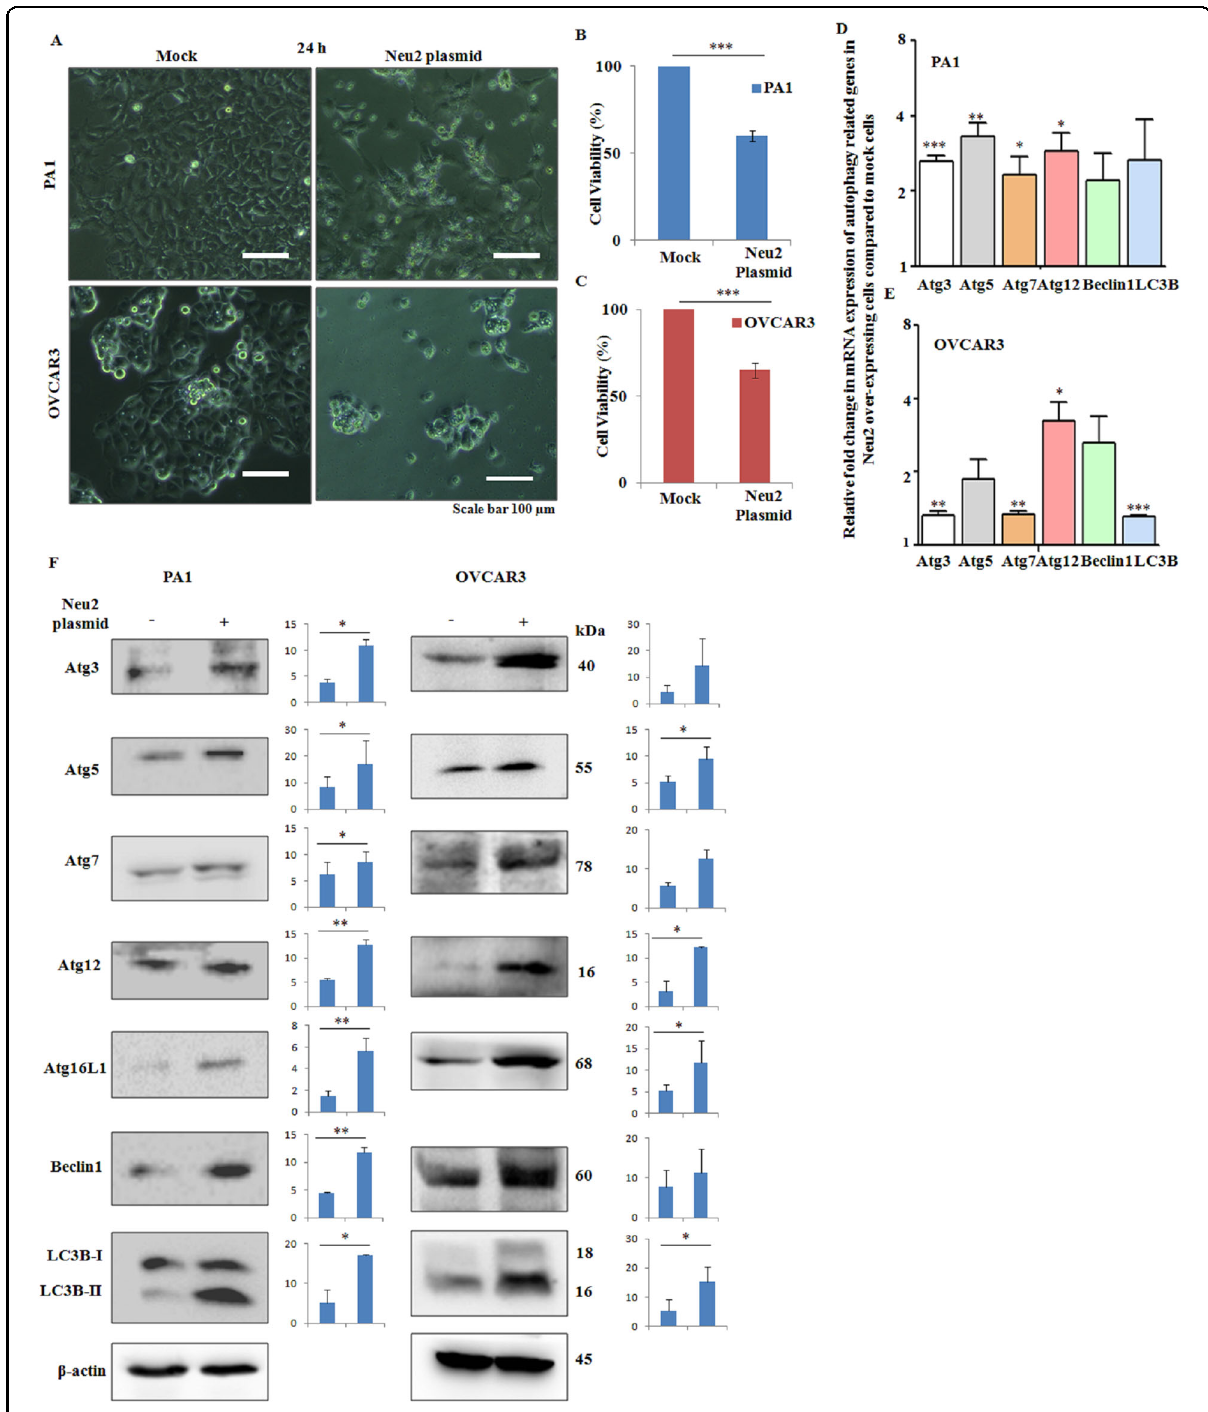
Fig. 2 Neu2 transfection induced decreased cell viability and increased autophagy-related molecules. A Reduced size and changed shape of Neu2-transfected PA1 and OVCAR3 cells compared to mock were visualized through the phase-contrast image. B , C Decreased cell viability in both PA1 ( B ) and OVCAR3 ( C ) after Neu2 transfection as determined by MTT assay. D , E Representative bar graphs showing the mRNA expression levels of autophagy-related molecules in Neu2-overexpressed PA1 ( D ) and OVCAR3 ( E ) compared to mock by real-time PCR. F Western blots showing the protein levels of autophagy-related molecules after 24 h of Neu2 transfection compared to mock in these cells. β -Actin was used as a loading control. The results are represented as mean ± SD from independent experiments and p values (* p < 0.05; ** p < 0.01; *** p < 0.001; two-tailed t test) represented the signi fi cant differences between the means of the two test groups.